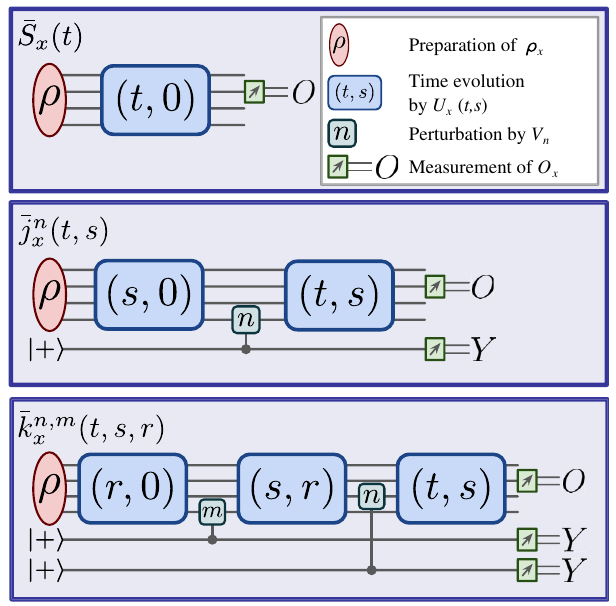
¯ FIG. 2. Circuits to estimate the signal S x ( t ) (top) and the inte- ( t , s ) (middle) and ¯ k n , m ( t , s , r ) (bottom) that are required grands ¯ j n x x to calculate the first and second derivatives of our cost func- tion C [ H ] [Eq. (4)]. For ease of viewing, we suppress labels in the circuits themselves (see the legend for clarification).